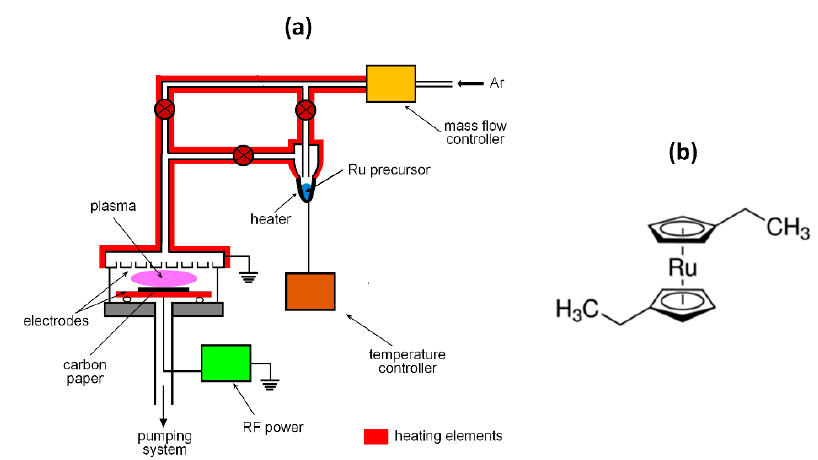
Figure 4. ( a ) schematic diagram of the RF plasma reactor used for deposition of Ru-based films; ( b ) chemical formula of the Ru-precursor.